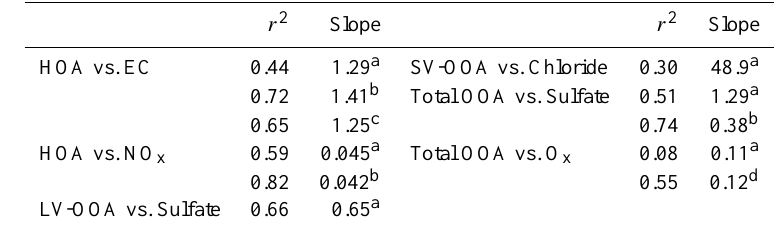
Table 2. Correlations between OA components and tracers from collocated